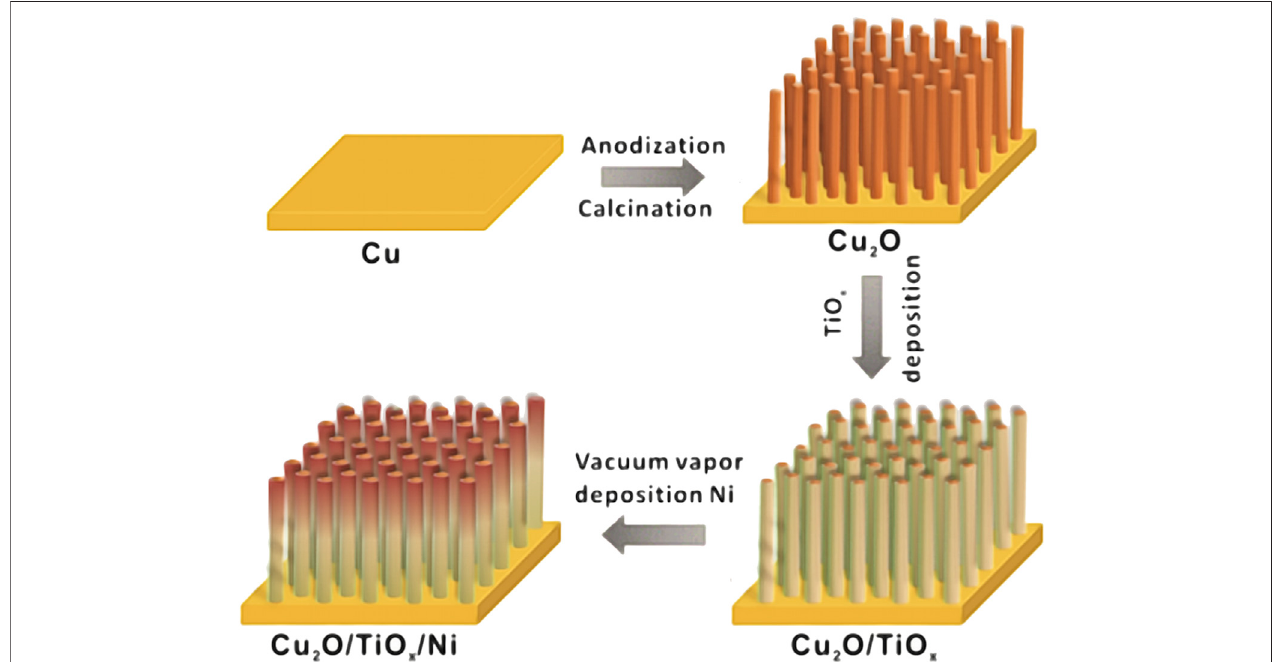
FIGURE 1 | Schematic illustration of synthetic procedure of Cu 2 O/TiO x /Ni-NWAs heterostructure fi lm.